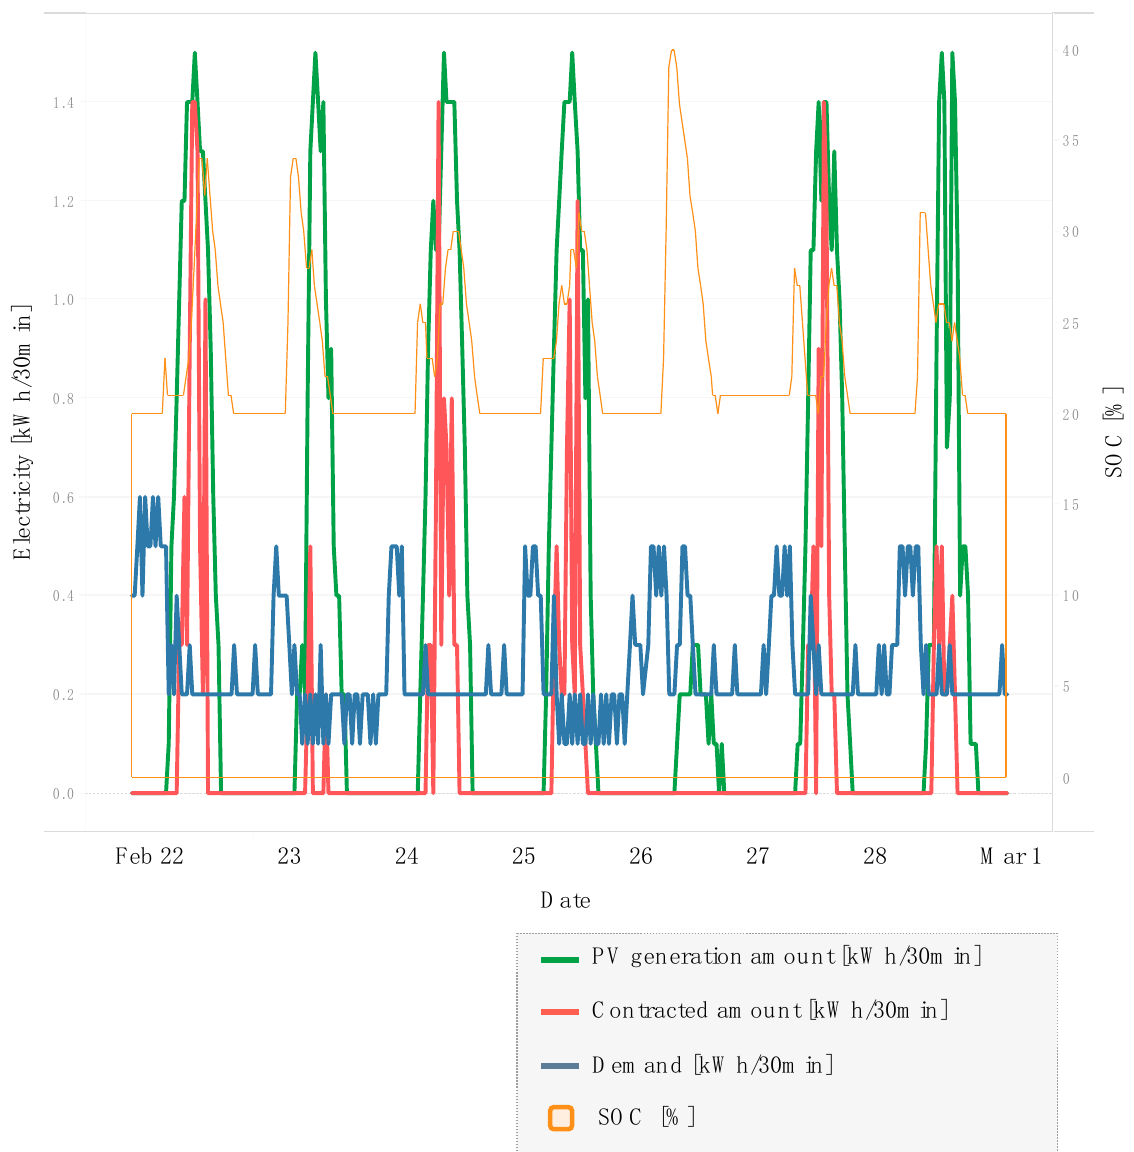
Figure 6. Changes in the status of users who own EVs in the first week.